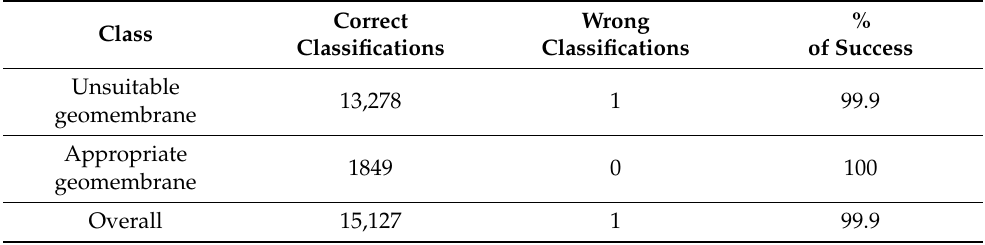
Figure 7. Evolution of the neural network MSE. Table 9. Results of classifications for training